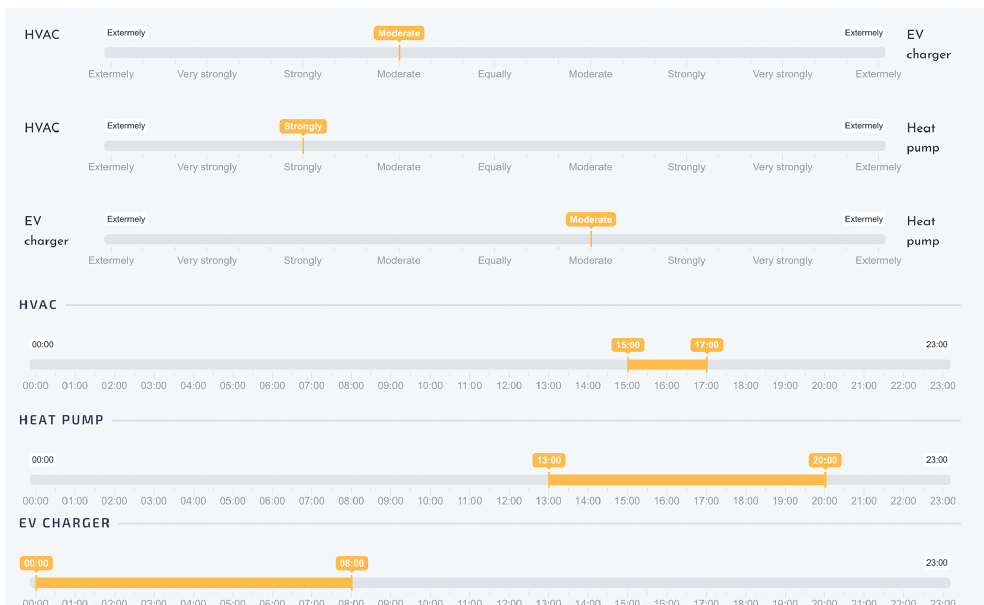
Figure 3. The implemented thermal comfort scale.